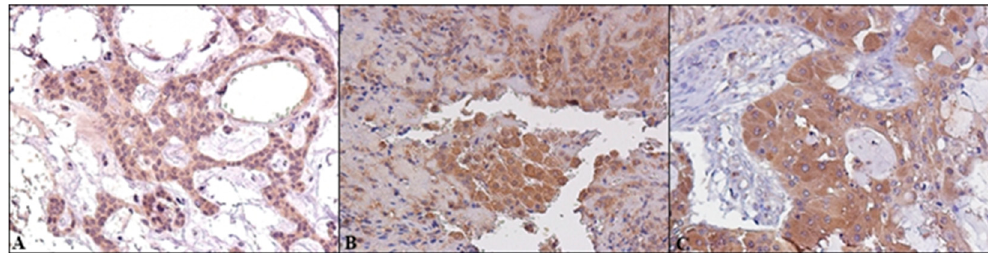
Figure 6. Cytoplasmic GPR30 IHC staining of SGTs samples: ( A ) PA; ( B ) Myoepithelioma; ( C ) MEC (Magnification 20×).